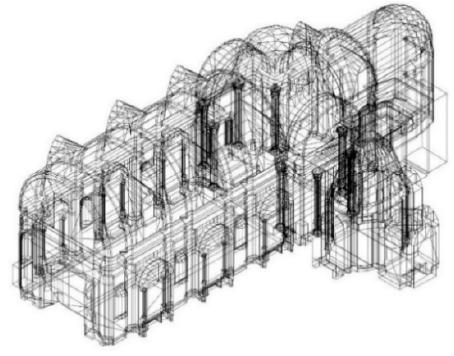
Figure 10. 3D model-S. Dominic of Foligno.